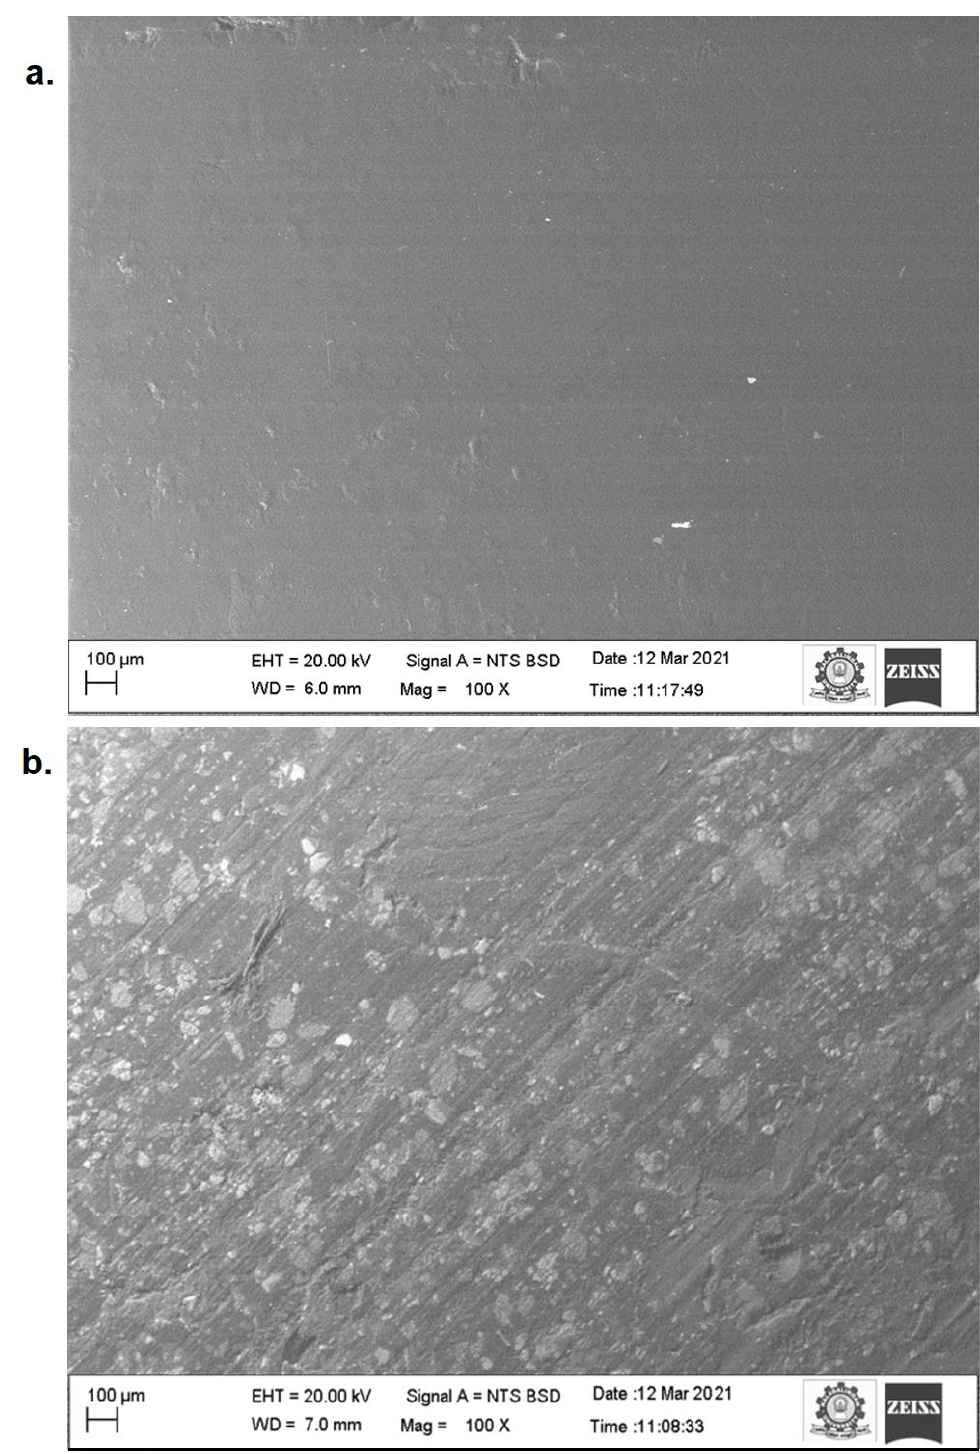
Figure 4. Sample with low COF and high wear rate (sample n.1): ( a ) Before wear test; ( b ) After wear test.